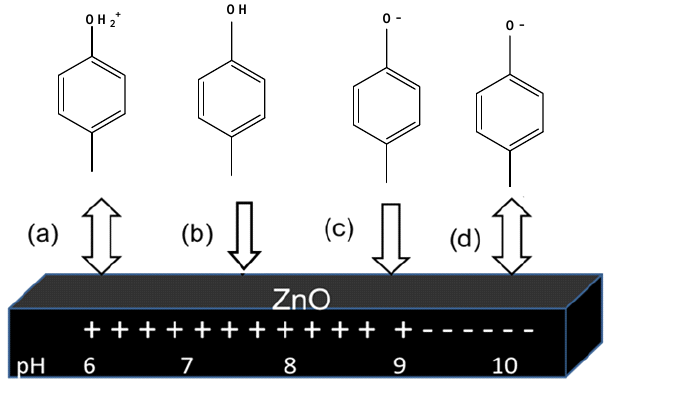
Figure 6. Schematic view of ZnO surface and p -cresol in different solution acidity. Several events are illustrated: ( a ) strong repulsion; ( b ) interaction; ( c ) strong attraction ( d ) strong repulsion.